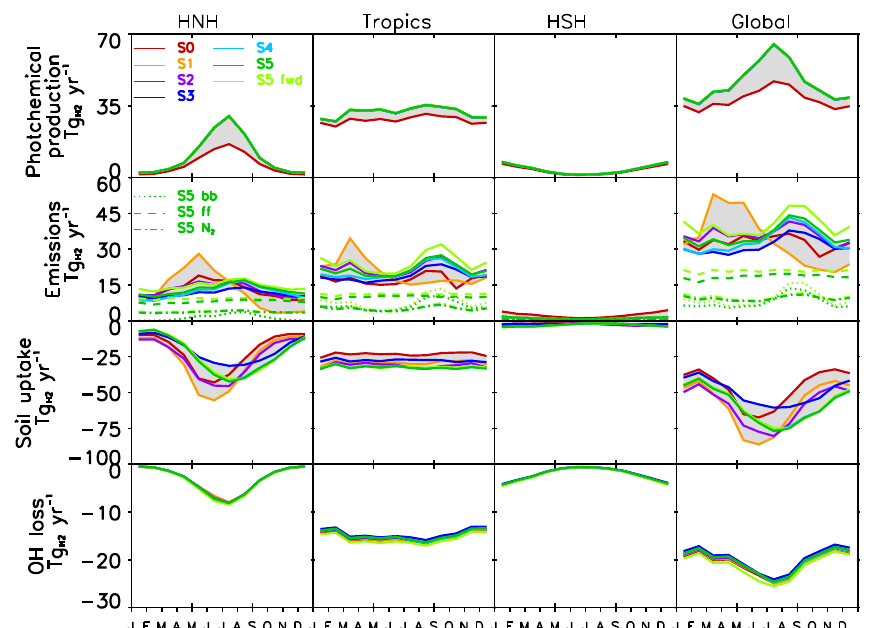
Fig. 6. Posterior seasonal cycle of H 2 fluxes for four regions (HNH: High North Hemisphere, 30 − 90 ◦ N; Tropics, between 30 ◦ N and 30 ◦ S; HSH: High Southern Hemisphere, 30–90 ◦ S). Each scenario is represented by a different color, S0 and S1 in red scale, S2 to S4 in blue scale and S5 in green. The prior emissions for the S5 scenario are plotted in light green and labelled S5 fwd. Separated emissions of S5 and S5 fwd are plotted with dots for the biomass burning emissions, with dashes for the anthropogenic emissions and with dashes-dots for the N 2 fixation-related emissions. The grey shaded area represents the spread between the different scenarios.